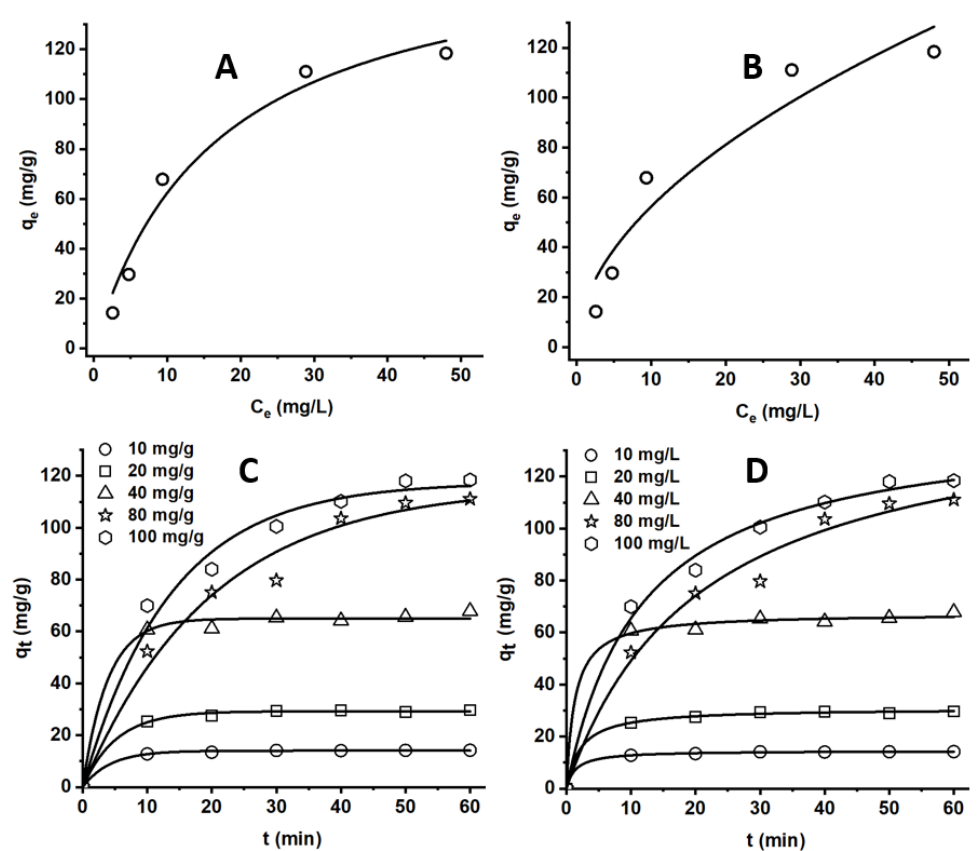
Figure 4. Non-linear ( A ) Langmuir and ( B ) Freundlich isotherm fitting curves; ( C ) Lagergren pseudo-first order and ( D ) pseudo-second order kinetic fitting curves obtained for the ARS dye adsorption onto the MCN.